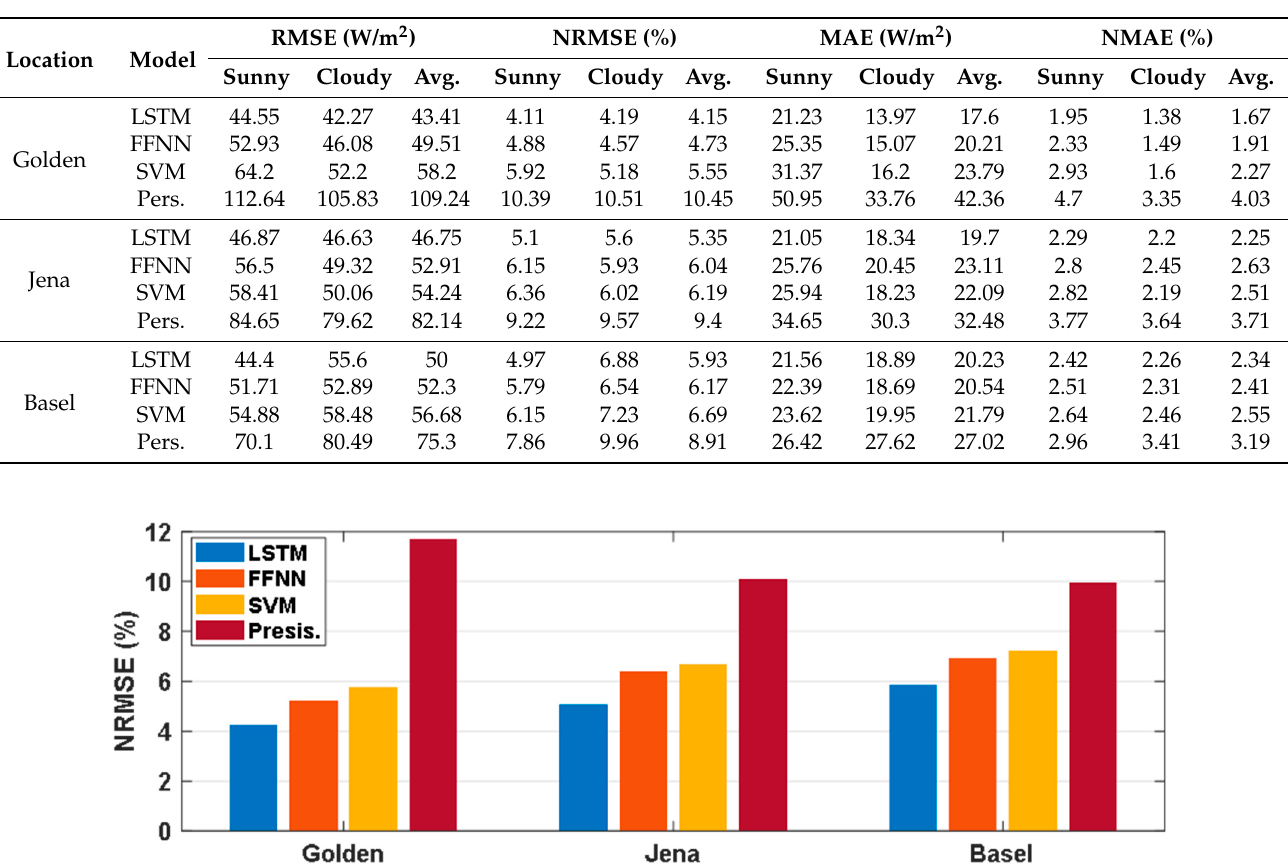
Table 5. The obtained results for the proposed hybrid model and other models.